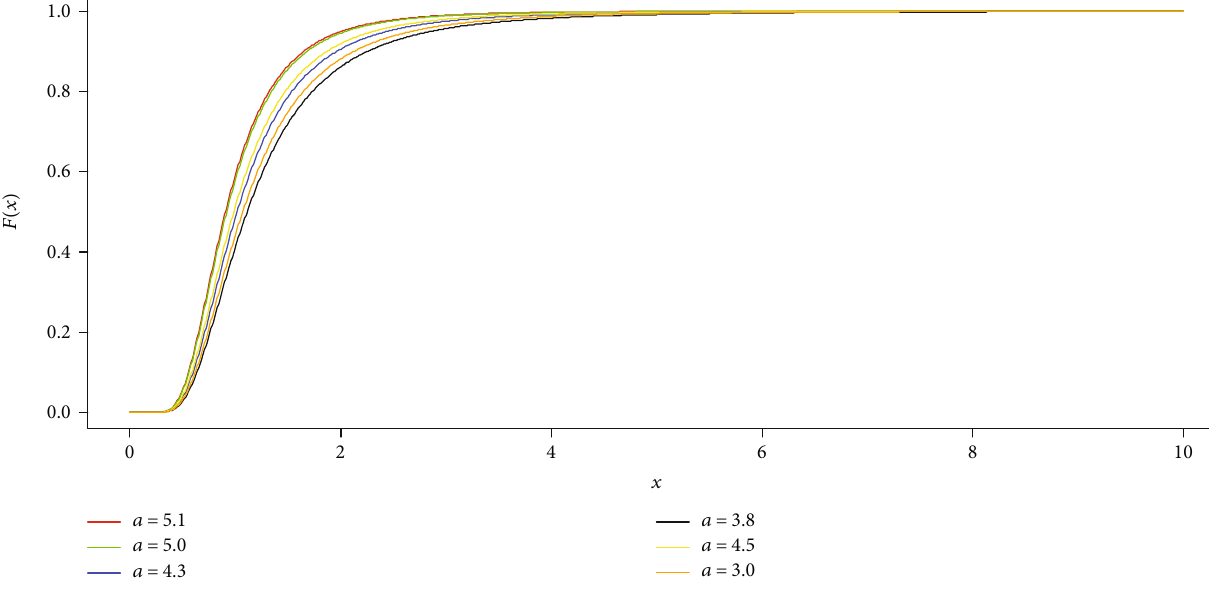
Figure 1: This illustration indicates that the EGTT has a true pdf.